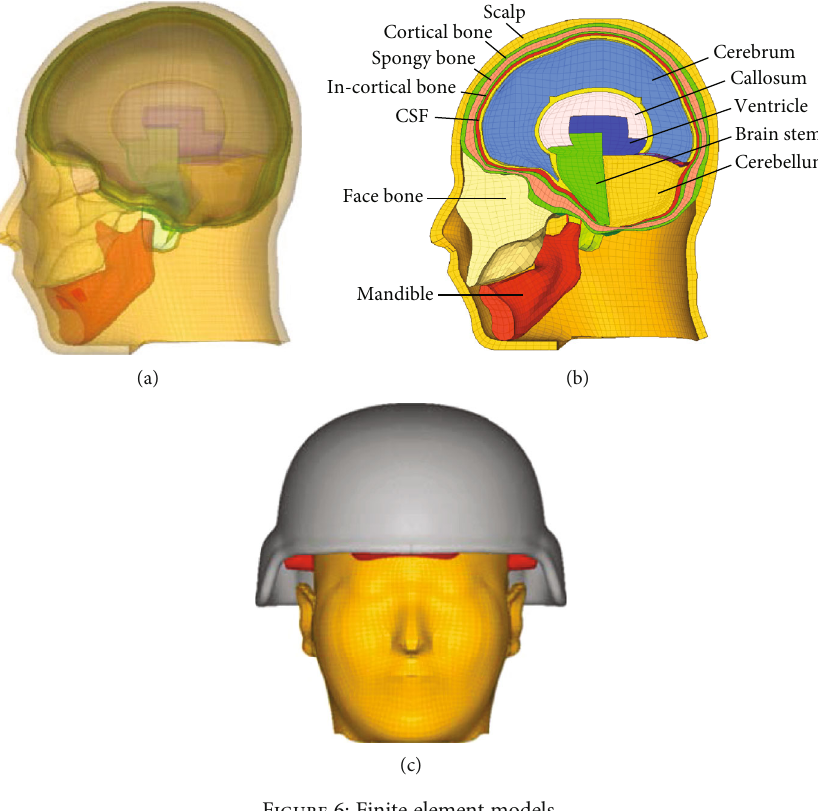
Figure 6: Finite element models.